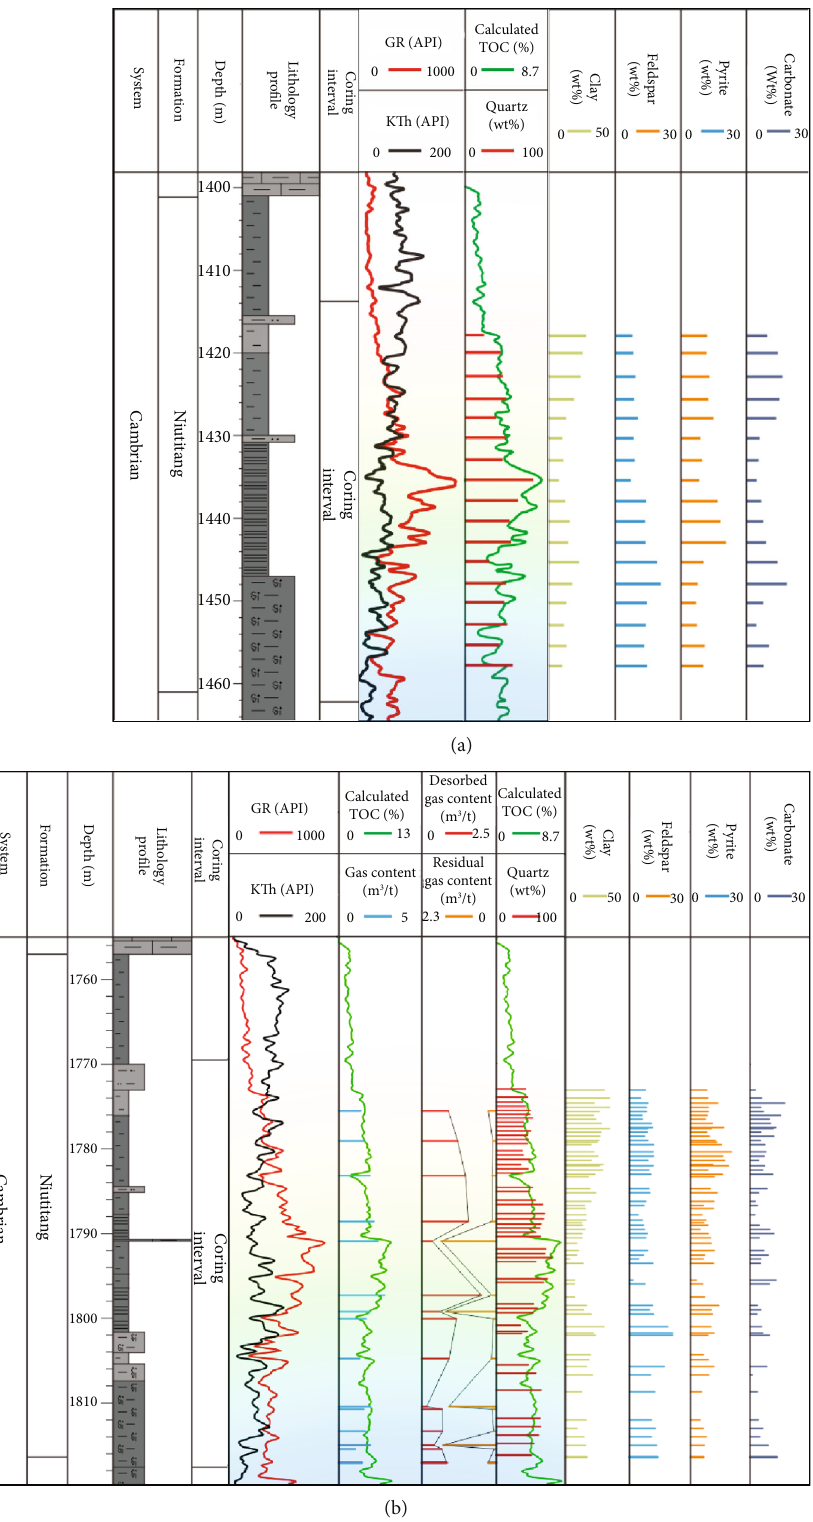
Figure 21: Relationship between the natural gamma curve and mineral composition of shale: (a) well CY-1 and (b) well